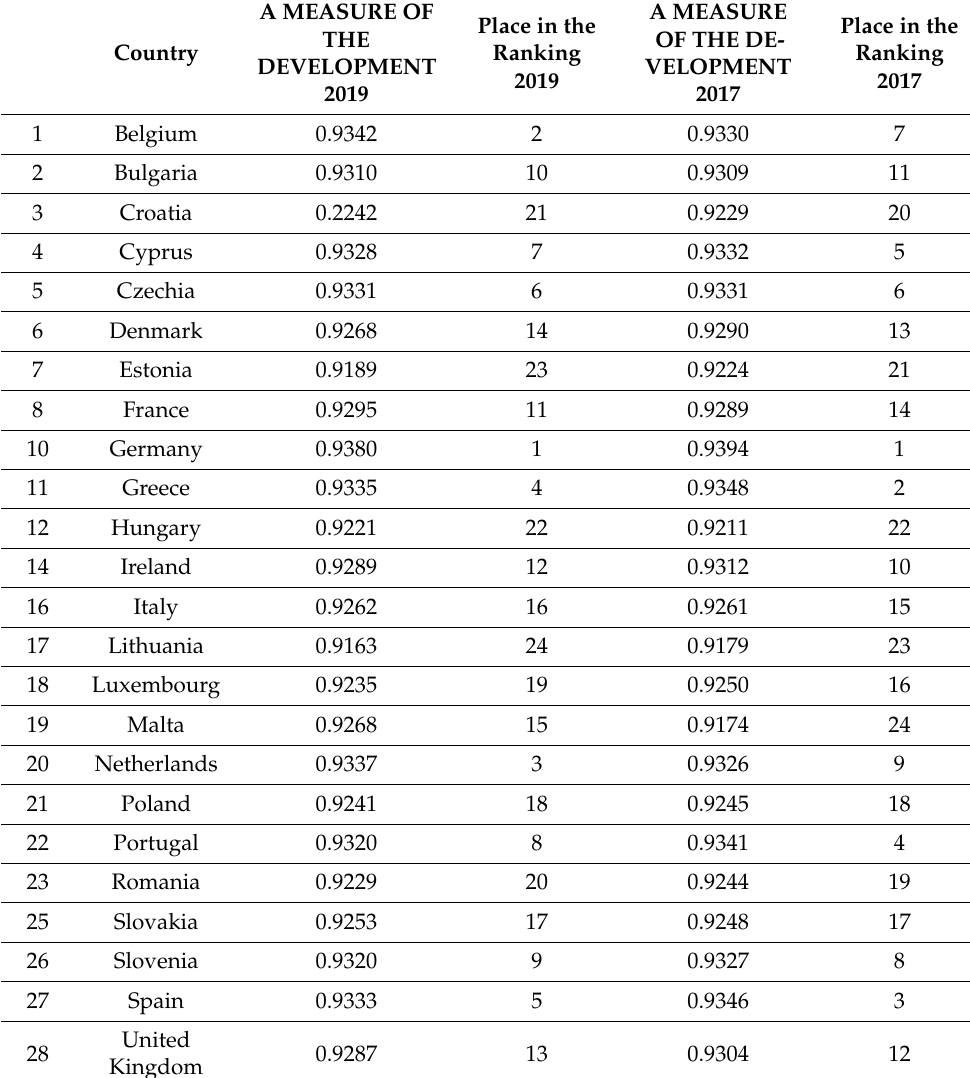
Table 4. A measure of the development for energy production in selected European Union countries in 2017 and 2019. A MEASURE A MEASURE OF Place in the Place in the OF THE DE- THE Ranking Ranking Country VELOPMENT DEVELOPMENT 2019 2017 2019